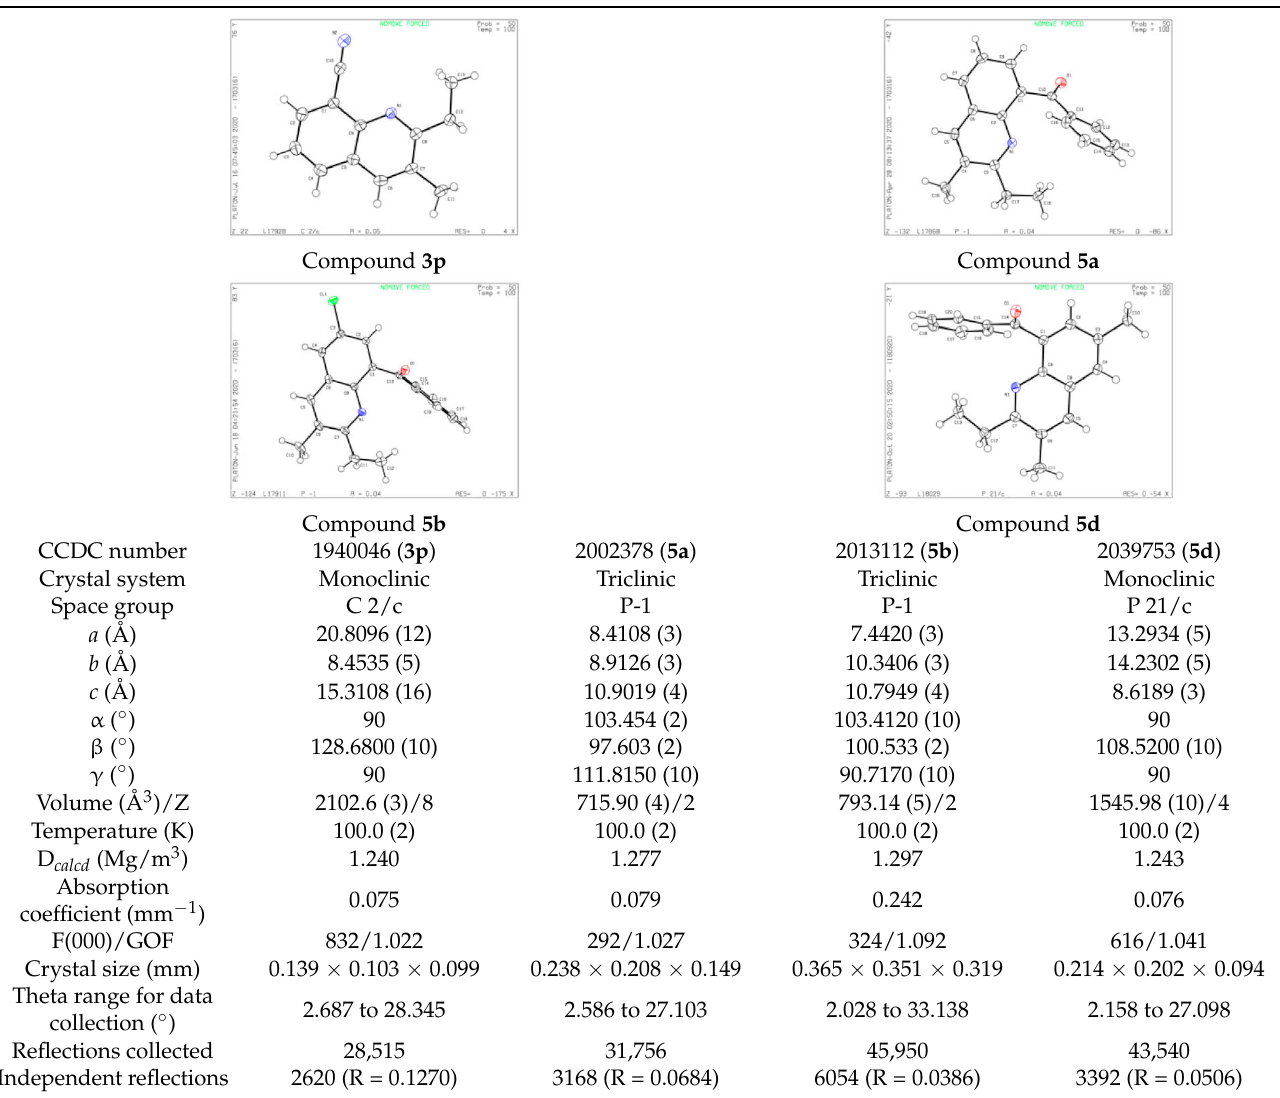
Table 2. Crystal data for compounds 3p , 5a , 5b and 5d